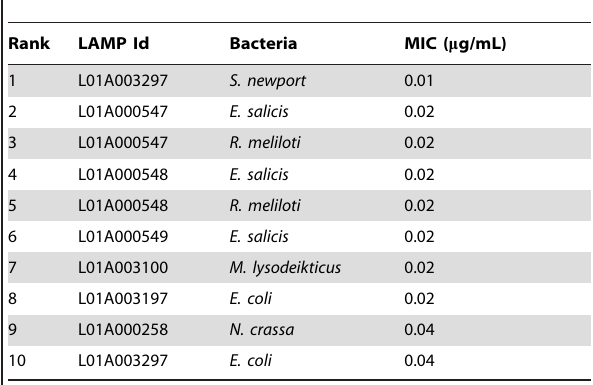
Table 3. Top 10 AMPs for antimicrobial activity in